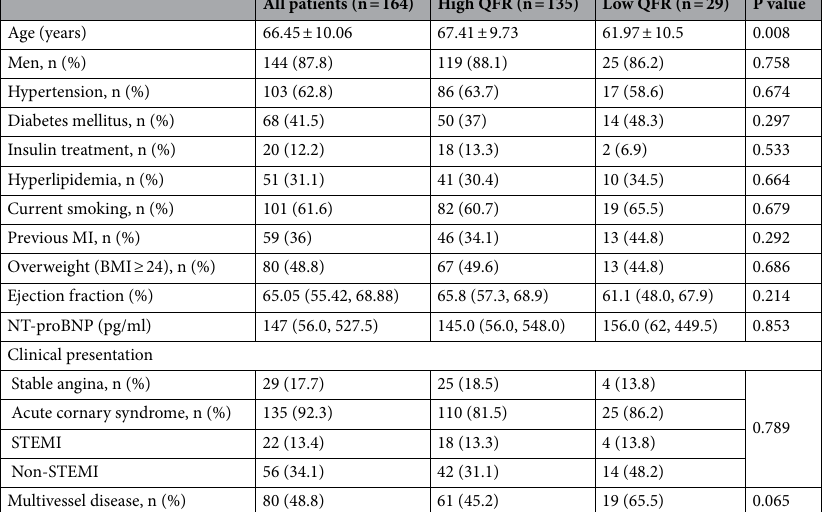
Table 1. Baseline characteristics of